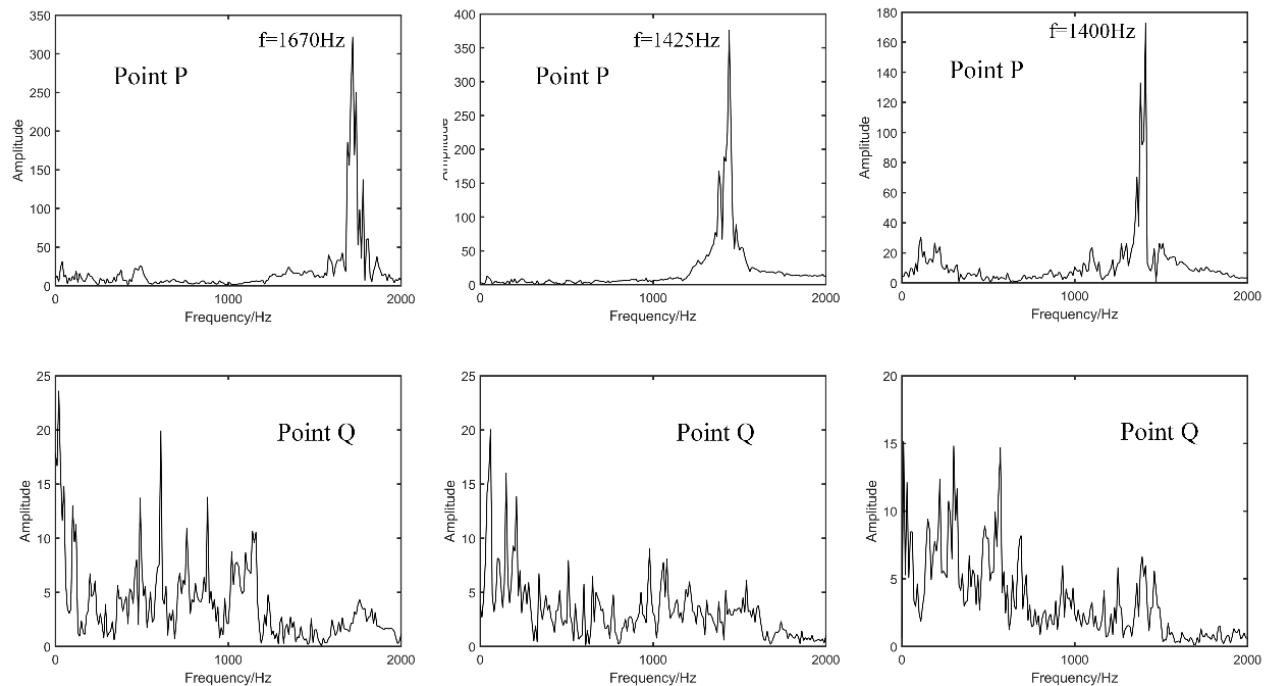
Figure 9. Spectrogram of axial pulsation velocity at different points (left: S = 0.44, mid: S = 0.60, right: S = 0.71).